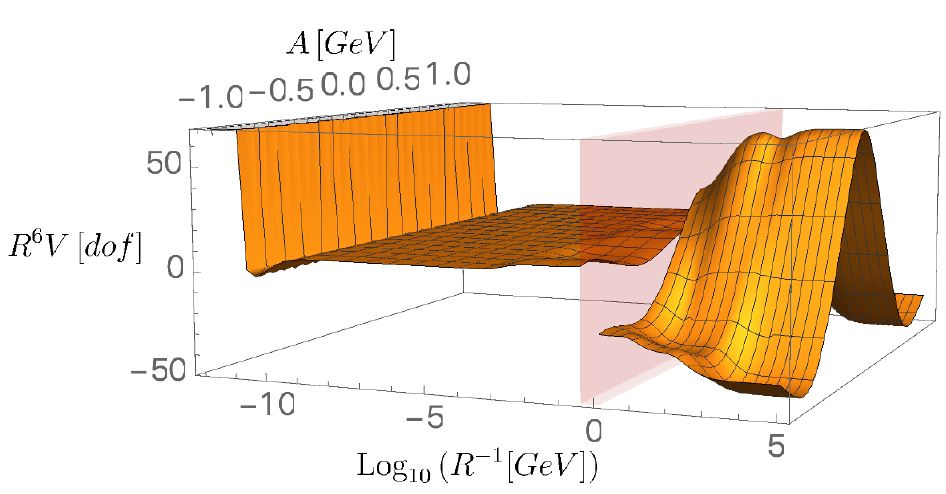
Figure 3 . E(cid:11)ective potential as a function of the photon Wilson line and the Radion, with the Higgs (cid:12)eld at the minima and all other Wilson lines set to zero. Notice that a runaway develops along the Radion direction for a non-zero value of the Wilson line.